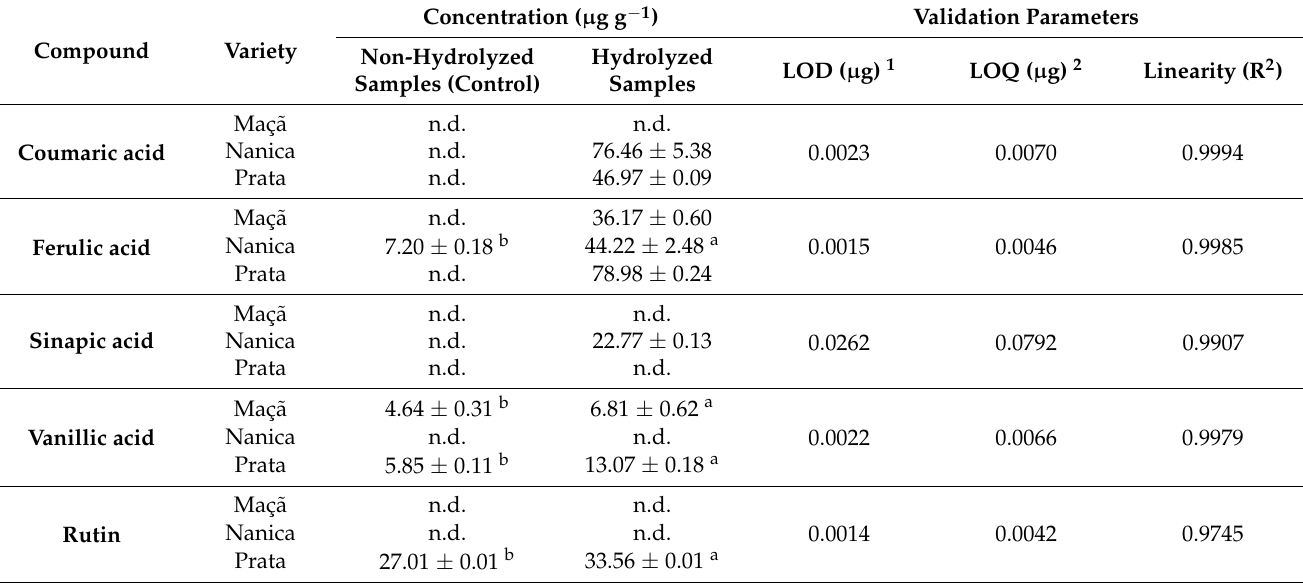
Table 5. Quantification by HPLC of phenolic compounds from banana bracts extracts after enzymatic hydrolysis using the ternary mixture of pectinase, protease and